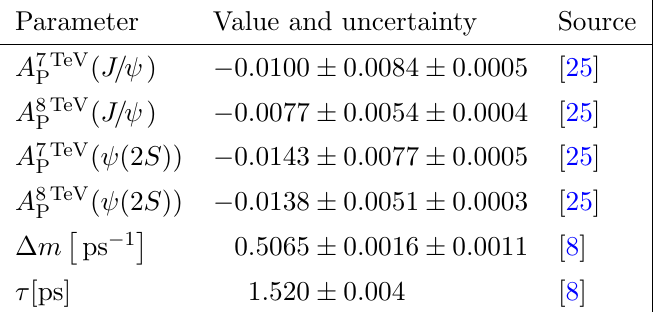
Table 2 . Parameters used as external inputs in the decay-time-dependent (cid:12)t. The production asymmetries are evaluated individually for both decay modes and separately for the di(cid:11)erent centre- of-mass energies of 7 and 8 TeV. If two uncertainties are given the (cid:12)rst is statistical and the second systematic. If one uncertainty is given it includes statistical and systematic